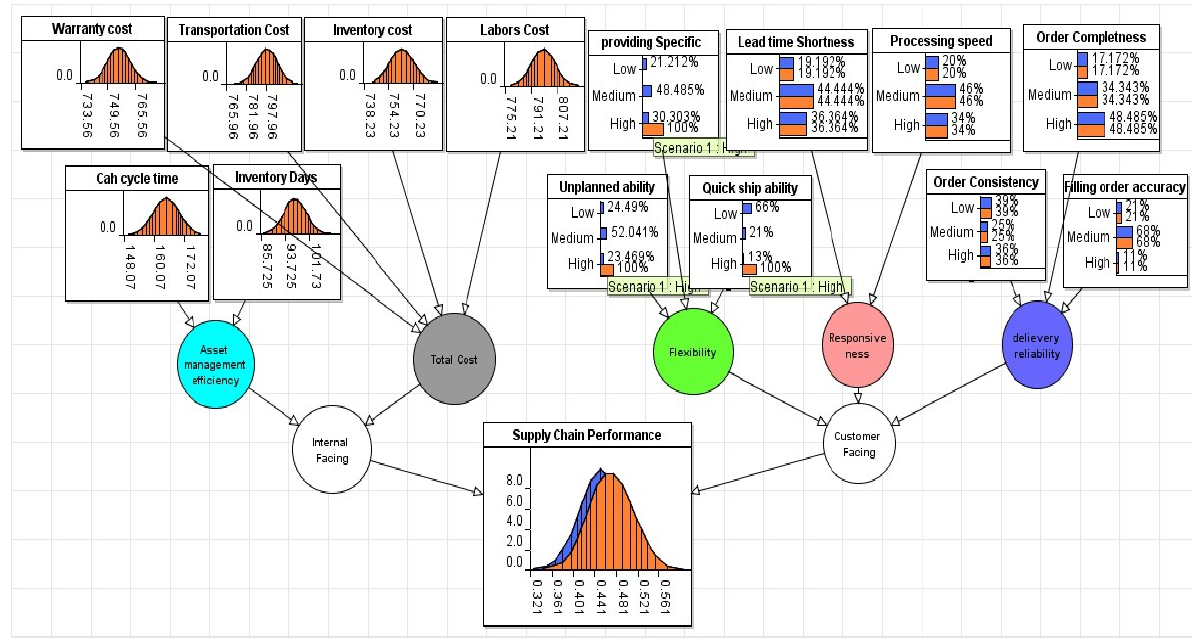
Figure 2. Model statue when Flexibility parents are in High